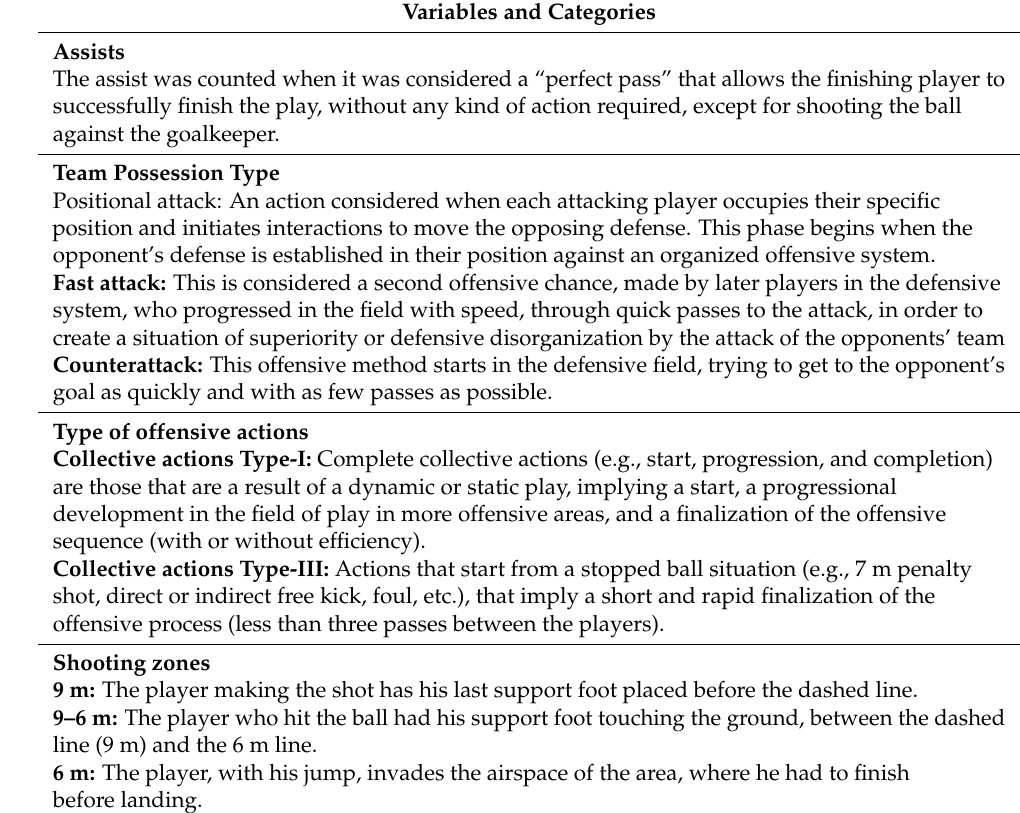
Figure A4. Linear tendency lines for the effectiveness in shooting. Note: QF = Quarterfinals; SF = Semifinals; F = Finals. Table A1. Description of variables and definitions of categories used in the team match perfor- mance